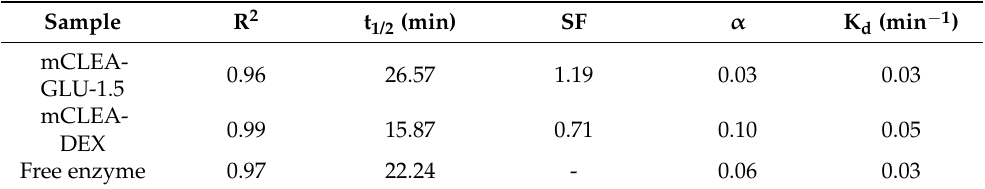
Table 6. Sadana and Henley model parameters for thermal inactivation at 60 ◦ C of free enzyme and magnetic β -galactosidase CLEA biocatalysts produced with glutaraldehyde and dextran-aldehyde.